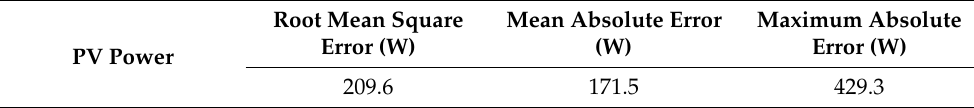
Table 7. Performance indices of the compensation of PV power data.